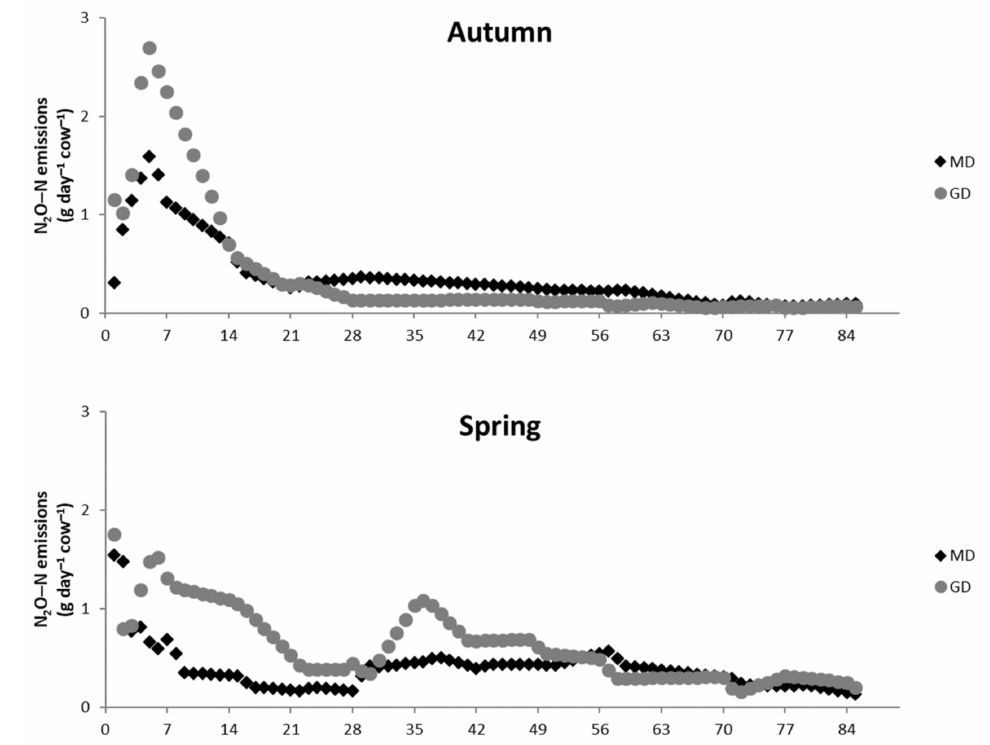
Figure 7. Dynamics of nitrous oxide (N 2 O–N) emissions (g d –1 cow -1 ) over the 85 d of storage in the autumn and spring as a function of diet (a maize-silage-based diet (MD) or a grass-based diet